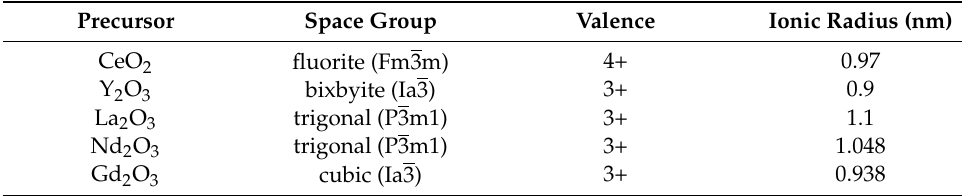
Table 1. Properties of the precursor oxides used in this study.